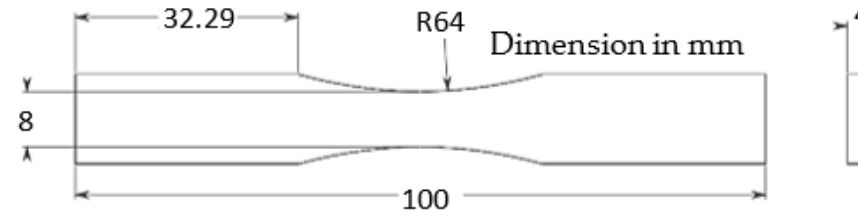
Figure 8. Geometry of samples for fatigue test.